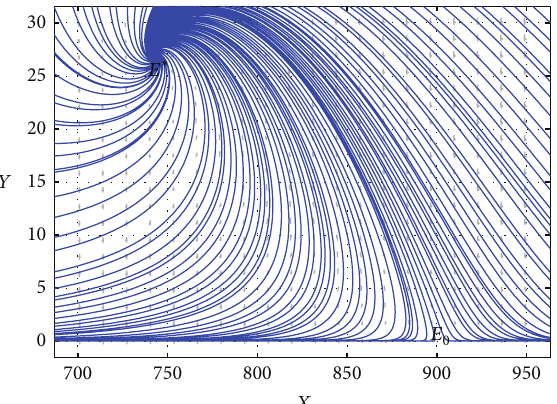
Figure 3: Phase plane of 𝑋 − 𝑌 with 𝐴 = 9 , 𝑑 = 0.1 , 𝑎 = 0.001 , = 0.1 , and 𝑐 = 0.5 (color online). Figure 4: Phase plane of 𝑋 − 𝑌 with 𝐴 = 90 , 𝑑 = 0.1 , 𝑎 = 0.001 , 𝑏 = 0.01 , 𝑐 1 2